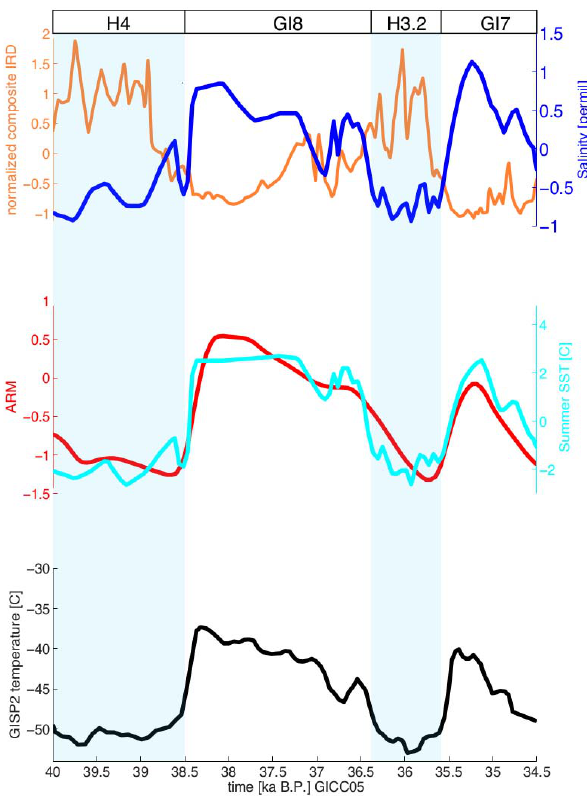
Fig. 11. Top panel: composite IRD record (orange) obtained from the average of the normalized northern North Atlantic IRD records SO82-5 (van Kreveld et al., 2000) and PS2644 (Voelker et al., 2000) (see Fig. 1) and Irminger Sea sea-surface salinities (blue) from SO82-5 (van Kreveld et al., 2000); middle panel: North Atlantic marine sediment cores ARM data (red) (Kissel et al., 2008) and Summer SST anomalies (cyan) from marine sediment core SO82- 5 (van Kreveld et al., 2000); bottom panel: GISP2 reconstructed central Greenland temperatures (black) (Alley, 2000). All data are displayed on the GICC05 timescale (see Fig.